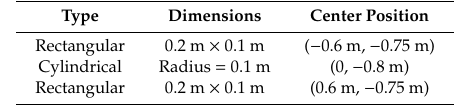
Table 1. Target characteristics for Example 1.